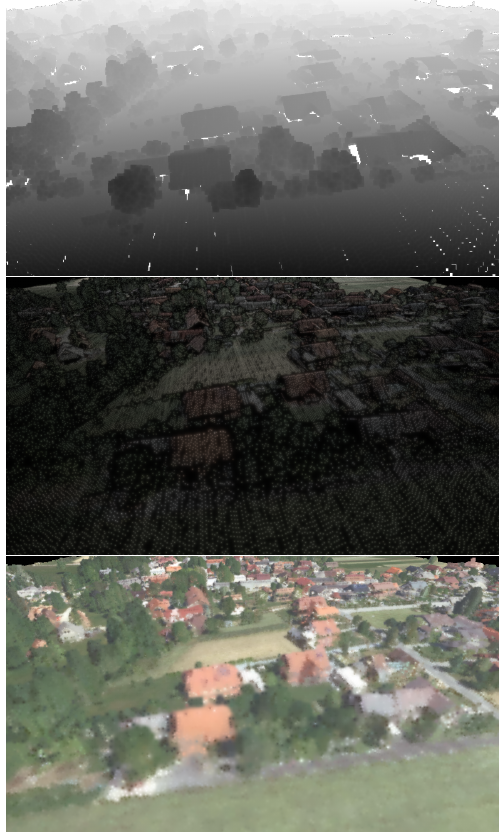
Figure 4. From left to right: step 1—depth map of occlusion points, step 2—filtering occluded points, step 3—final rendering using